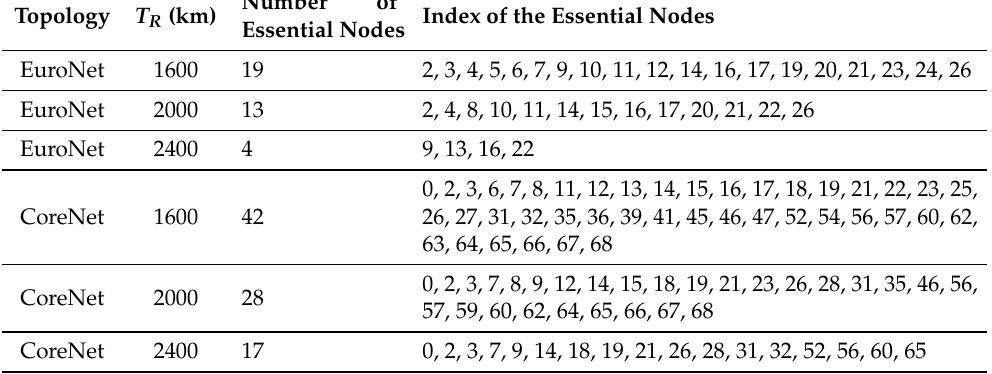
Table 1. Total amount and node indexes of the essential nodes found for EuroNet and CoreNet topolo- gies considering different transmission reaches of T R = 1600km, T R = 2000km, and T R = 2400km. Number of Topology T R (km) Index of the Essential Essential Nodes